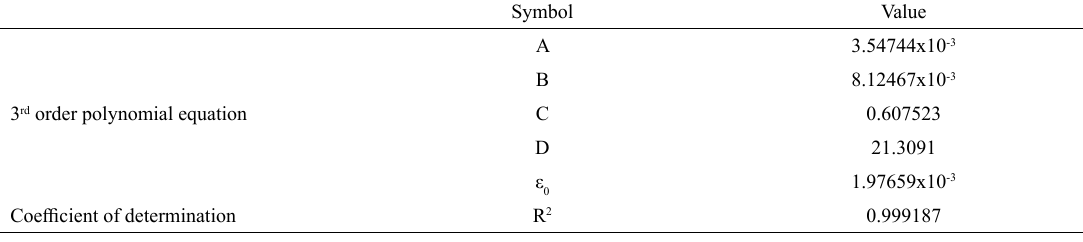
Table 3. Curve-fitting parameters for the third-order (ln )x(lnε) logarithmic curve.